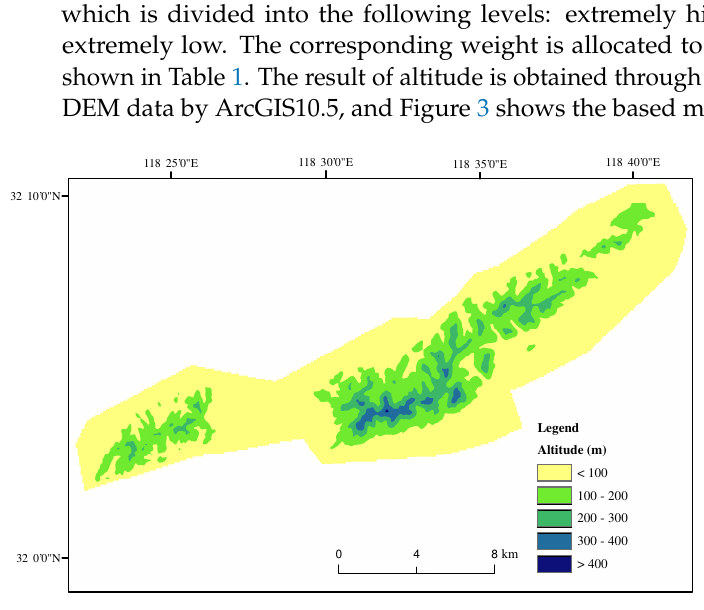
Figure 3. The base map of altitude in Laoshan. Each level is determined by the fire risk classification. Table 1. Fire risk classification of altitude.